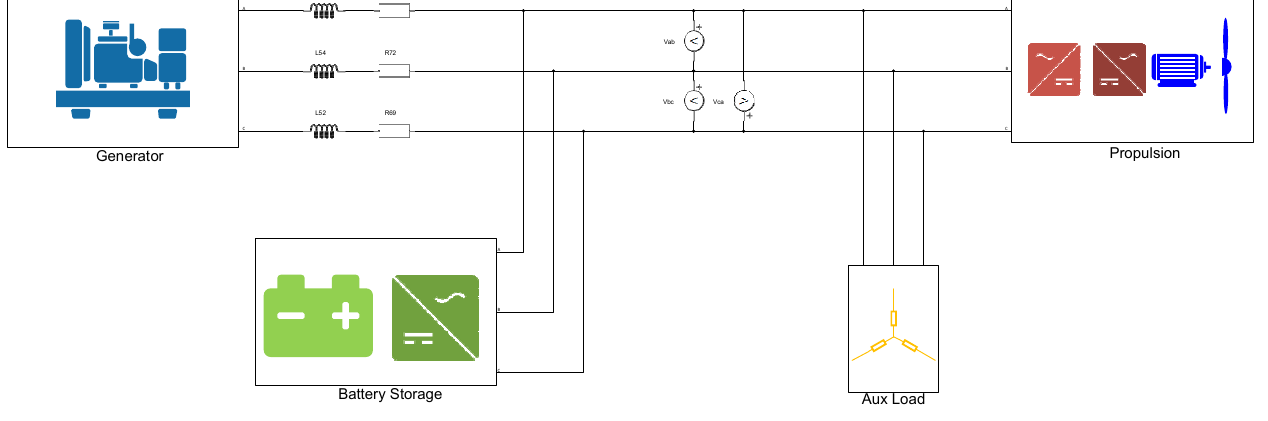
Figure 1. Architecture of the ship propulsion.